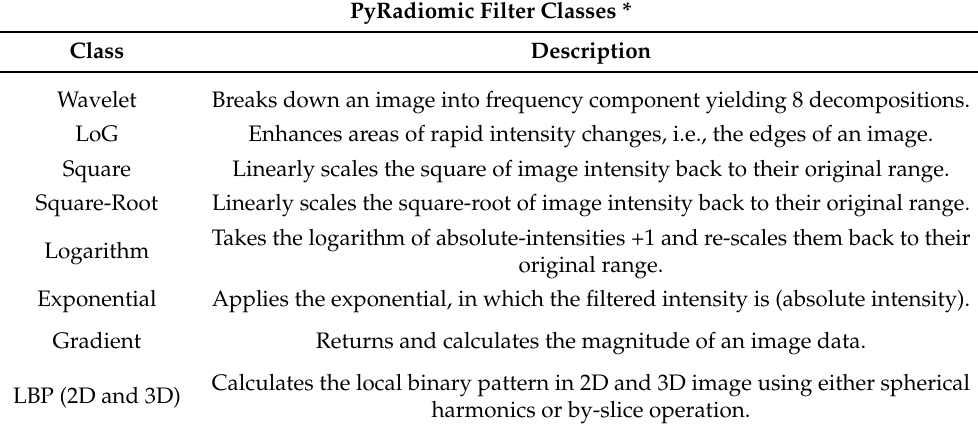
Table 2. Description of PyRadiomics filter classes. PyRadiomic Filter Classes *